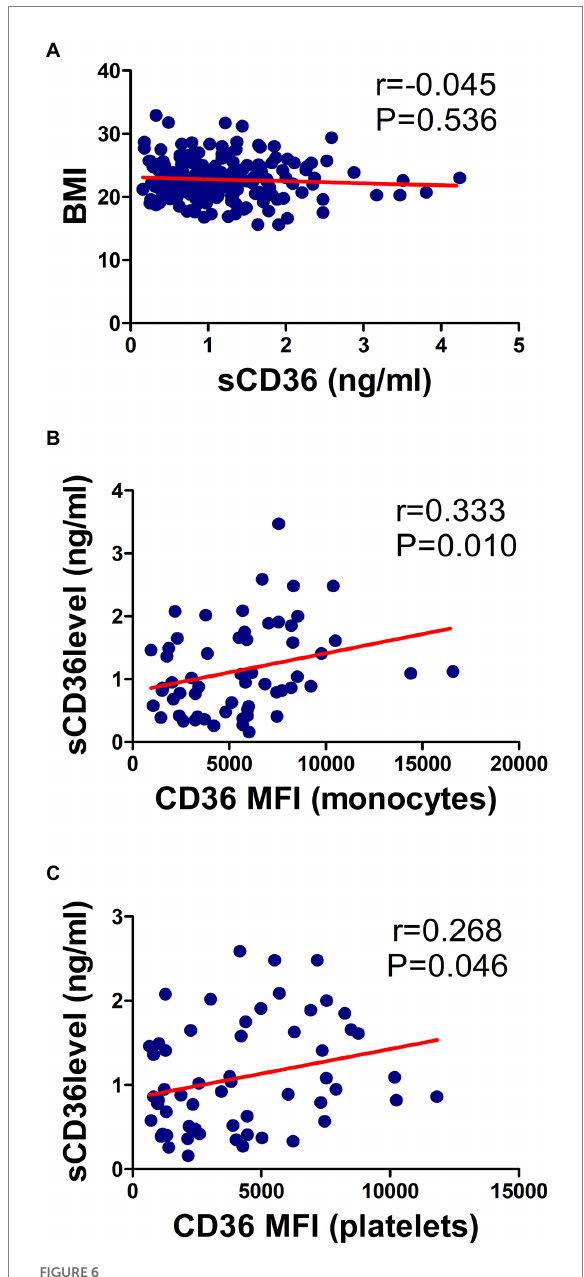
FIGURE 6 Correlation of sCD36 with body mass index (BMI), and CD36 expression on monocytes and platelets. (A) Correlation between sCD36 and BMI. (B) Correlation between sCD36 and CD36 expression on monocytes. (C) Correlation between sCD36 and CD36 expression on platelets. p values were calculated using the Spearman’s rank